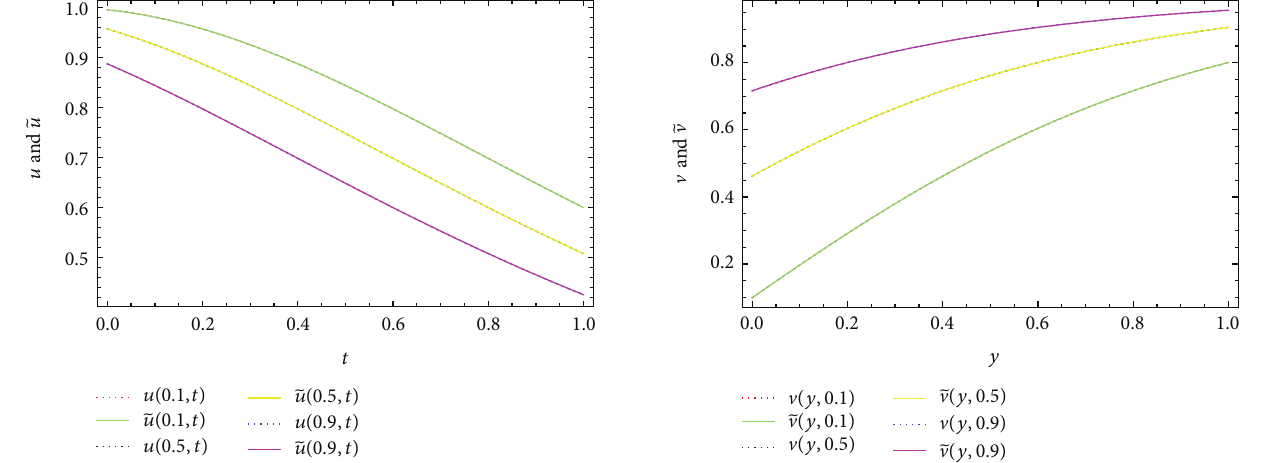
Figure 10: The approximate ̃𝑢 and the exact 𝑢 solutions for different values of 𝑦 = 0.1 , 0.5, and 0.9 of problem (51), where 𝑁 = 12 and 𝛼 = 𝛽 = −(1/2) in the interval [0,1] .